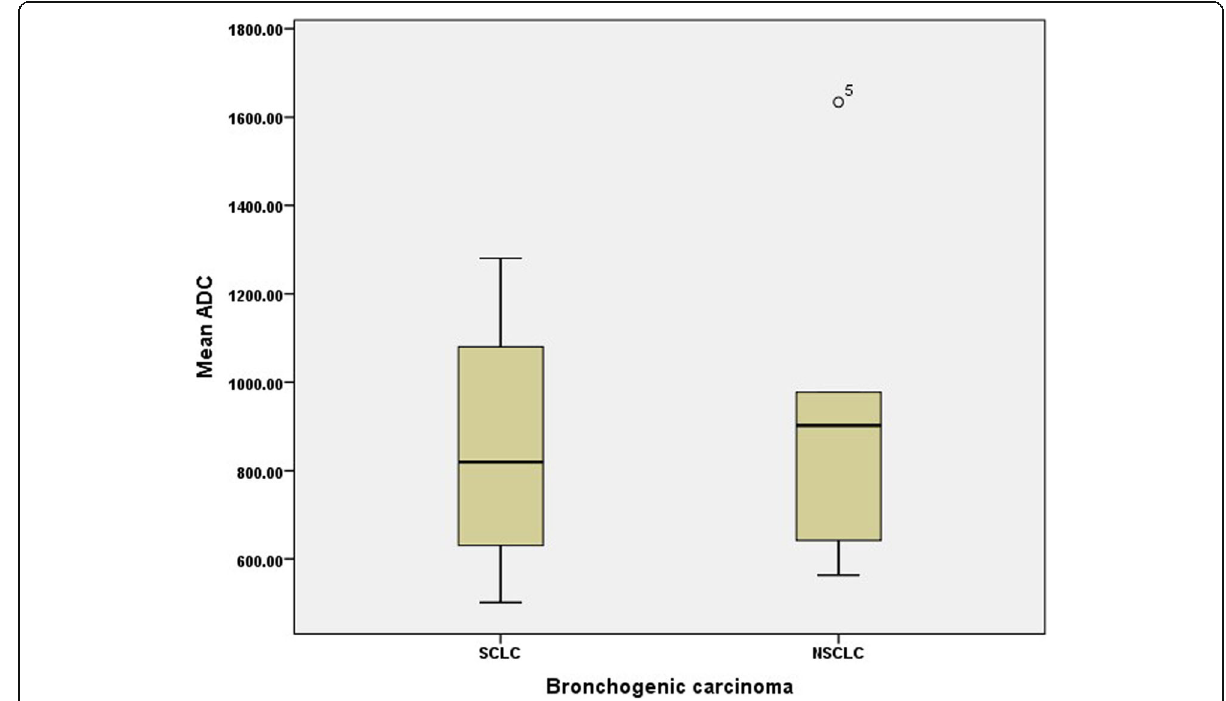
Fig. 9 Bar-and-Whisker plot: ADC mean values of SCLC and